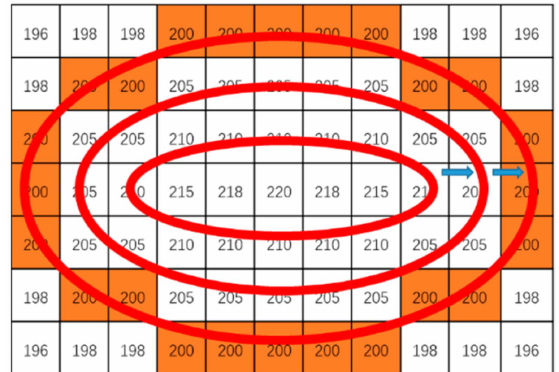
Figure 1. Annular convolution